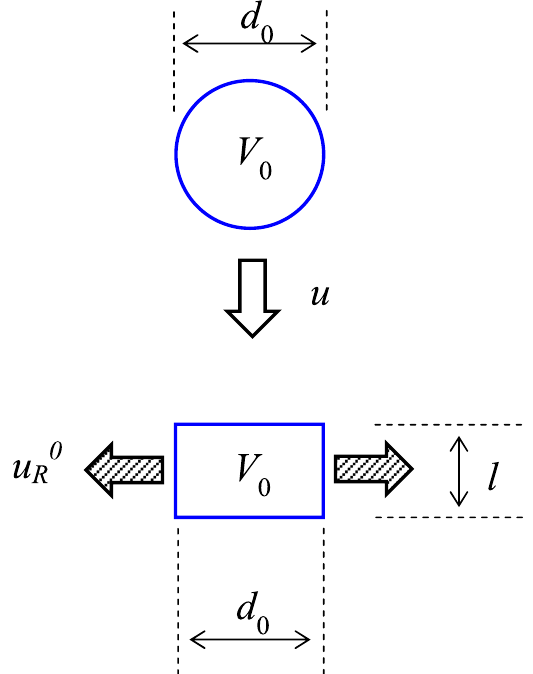
Figure 1. Simplified model to evaluate the radial velocity u R in the viscous dissipation term. In the schematic, u , V 0 , d 0 , u R0 and l represent the initial impinging velocity, droplet volume, droplet diameter, initial radial velocity and initial radial